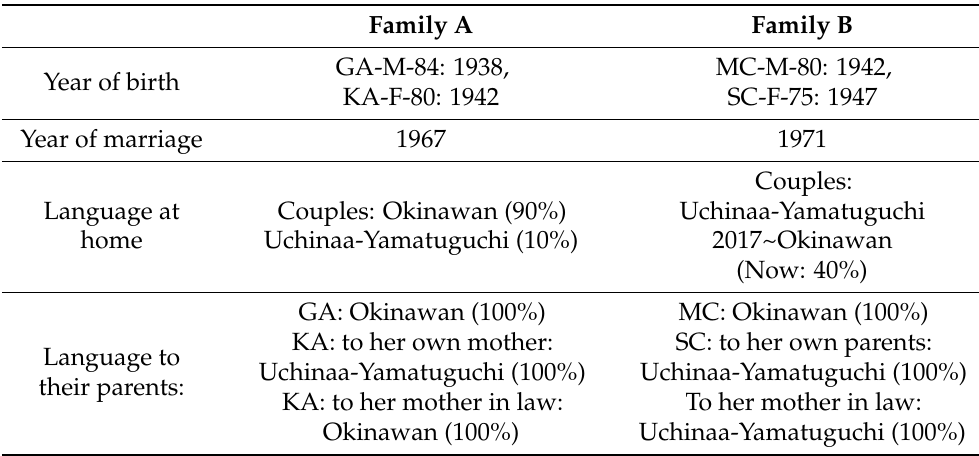
Table 3. Sociolinguistic profiles of the family A and